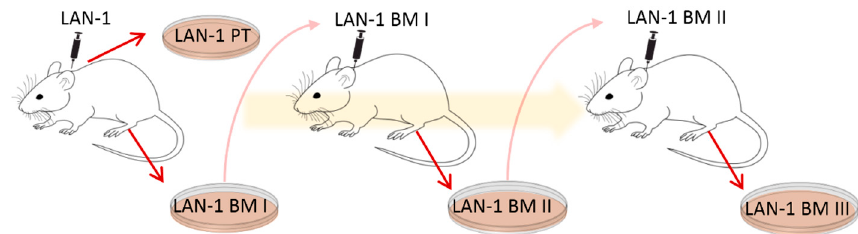
Figure 1. Scheme showing the serial injection of LAN-1